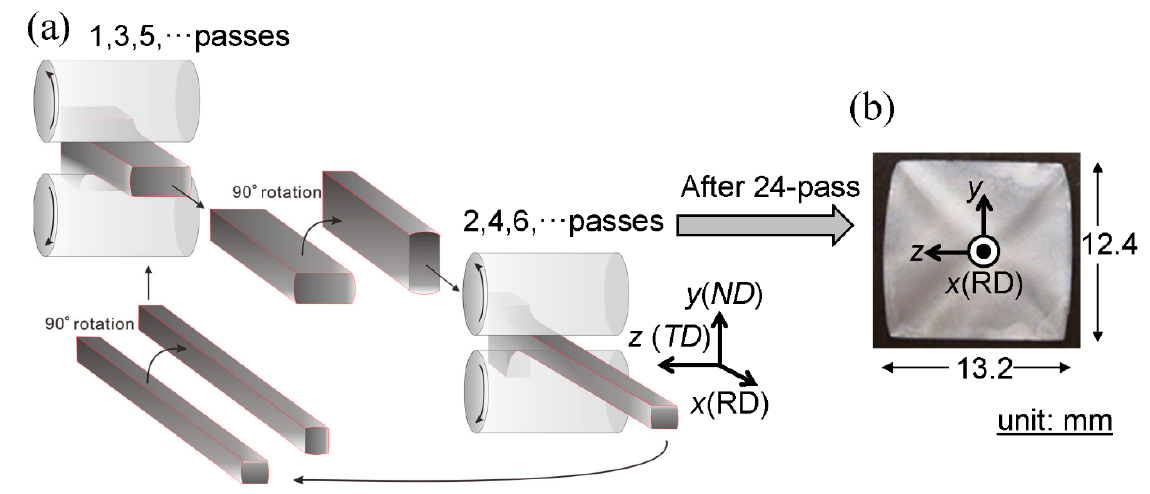
Figure 2. ( a ) Schematic illustration of the warm biaxial rolling (WBR) process and ( b ) a 13 mm square bar produced.